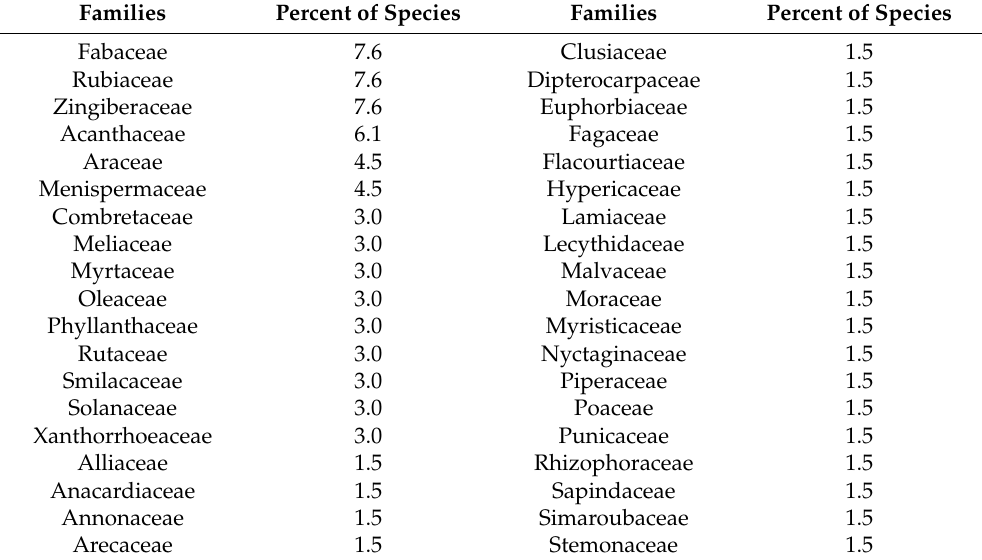
Table 3. Percentage of plant species in 38 families in polyherbal remedies used for skin